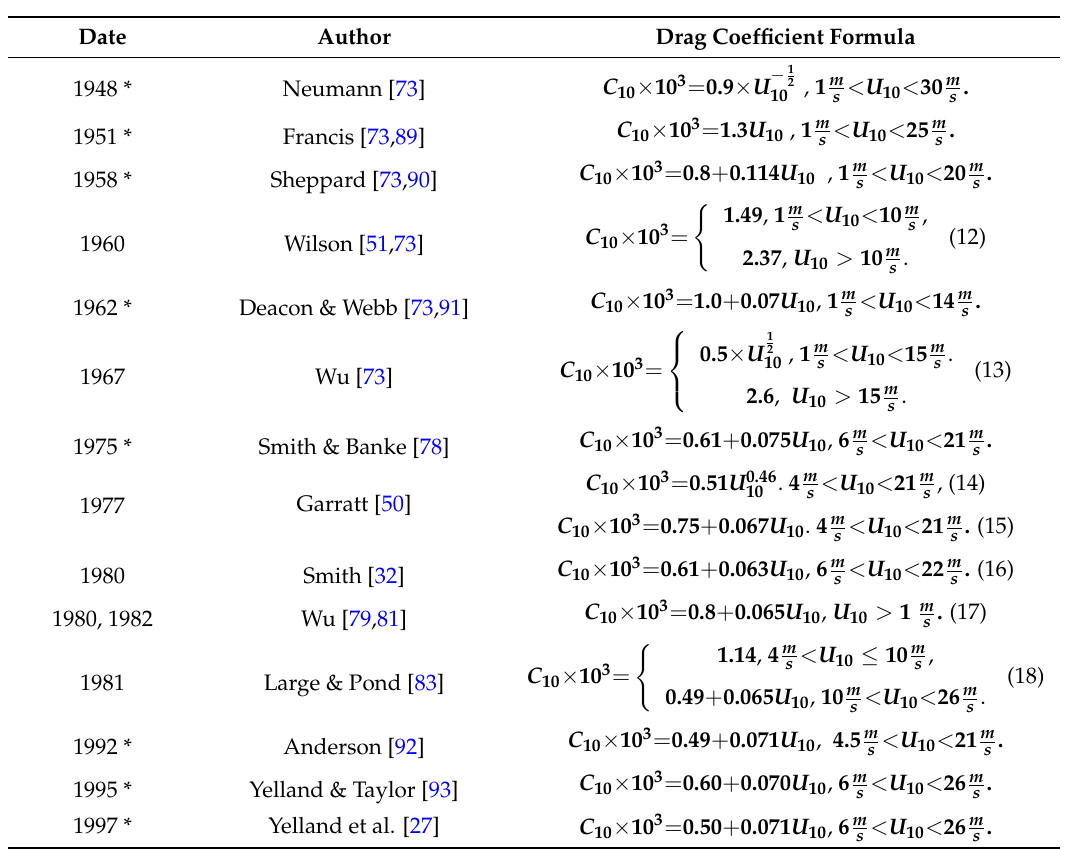
Table 1. Early Drag Coefficient Formulations